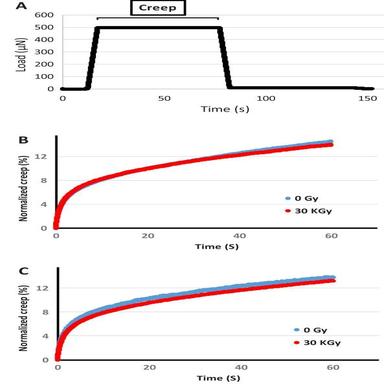
Indentation creep tests. An indentation load function was used to assess time-dependent creep at maximum loading force (A). Normalized creep of the EDJD (B) and PDJD (C) with or without x-ray irradiation. At least nine indentation datasets of each tooth (n. 6) were averaged. The mean values of each tooth were merged.